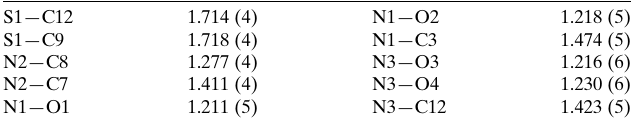
Table 1 Selected bond lengths (A˚ ).